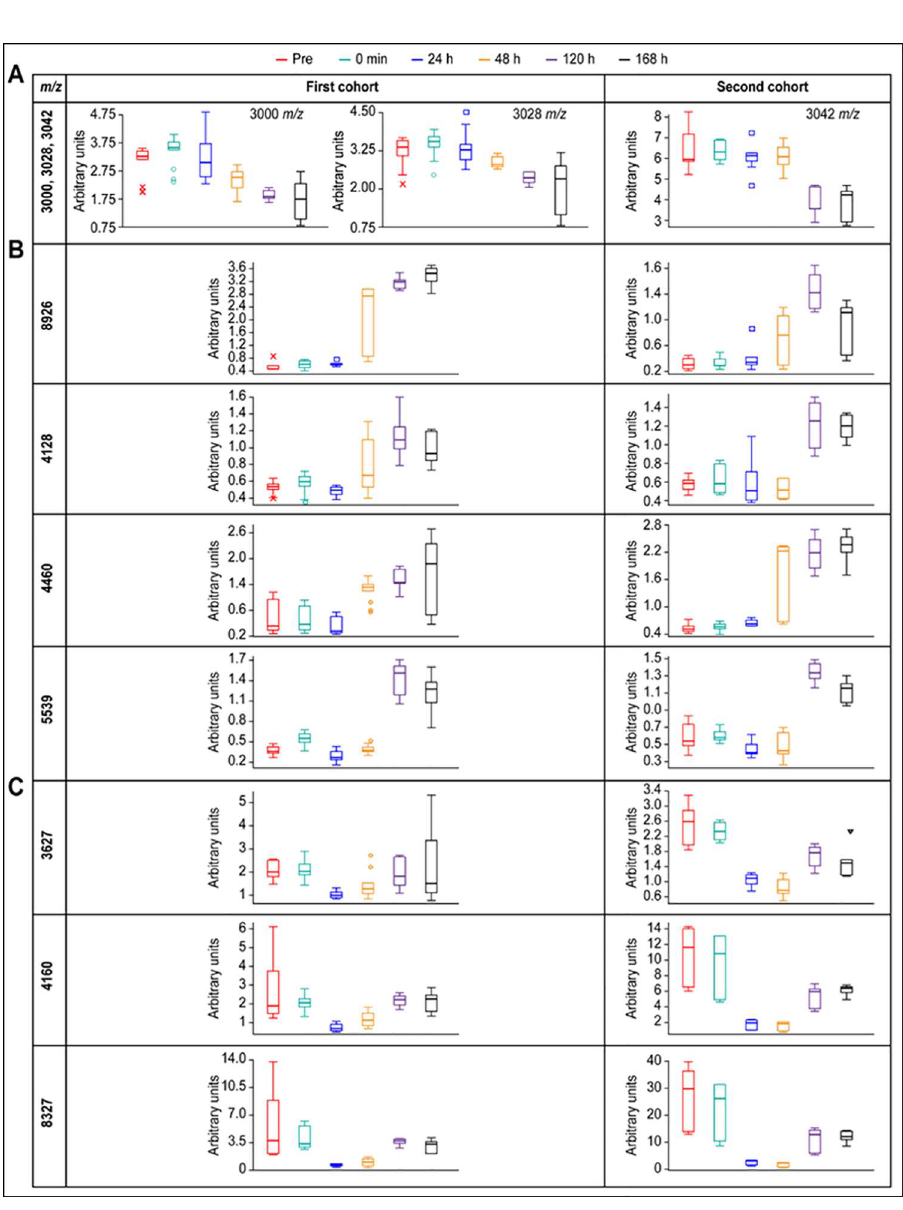
Fig 3. Box-and-whisker plots of the representative markersfor discriminating the phases after PHx. The discriminatory peaks were classifiedinto 3 groupsaccordingto the patterns of change; peptides (A) down-regulatedat recovery phase; (B) up-regulated at recovery phase; (C) down-regulated at acute phase. Pre (red), 0 min (light green), 24 h (blue), 48 h (yellow), 120 h (purple), 168 h (black). The top and bottom end marks of the plot indicatedthe maximum and minimumpeak area/intensity within a given class. The box indicatedthe 25%-quartile (bottom) and the 75%-quartile (top) and the horizontal intersection denotes the median.The statistical data were detailed in S3 Table. The plot was drawn on a uniquescale independentof the peak intensity scale. The identifiedpeaks were as follows; 3000: ALB, 25–49 * 1 ; 3028: ALB, 25–49 * 2 , 3042: ALB, 25–50, 8926: ALB, 25–103,3627: HBA, 1–36. * 1: Gly - > Ser: 22, * 2: Q - > deamidated: 18. m/z , mass to charge ratio; ALB, albumin; HBA, hemoglobin subunit α .